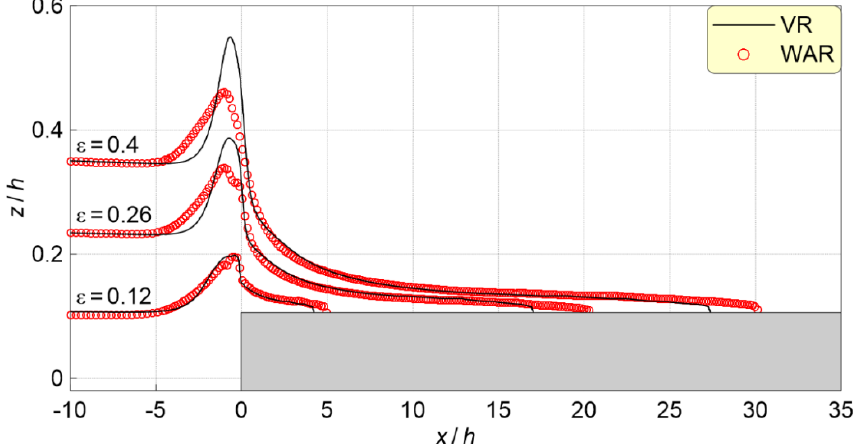
Figure 24. Spatial distributions of maximum water surface elevations around the VR and WAR.